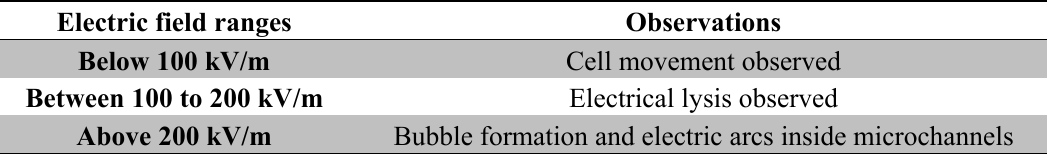
Table 2. Key observations with various electric field strengths.